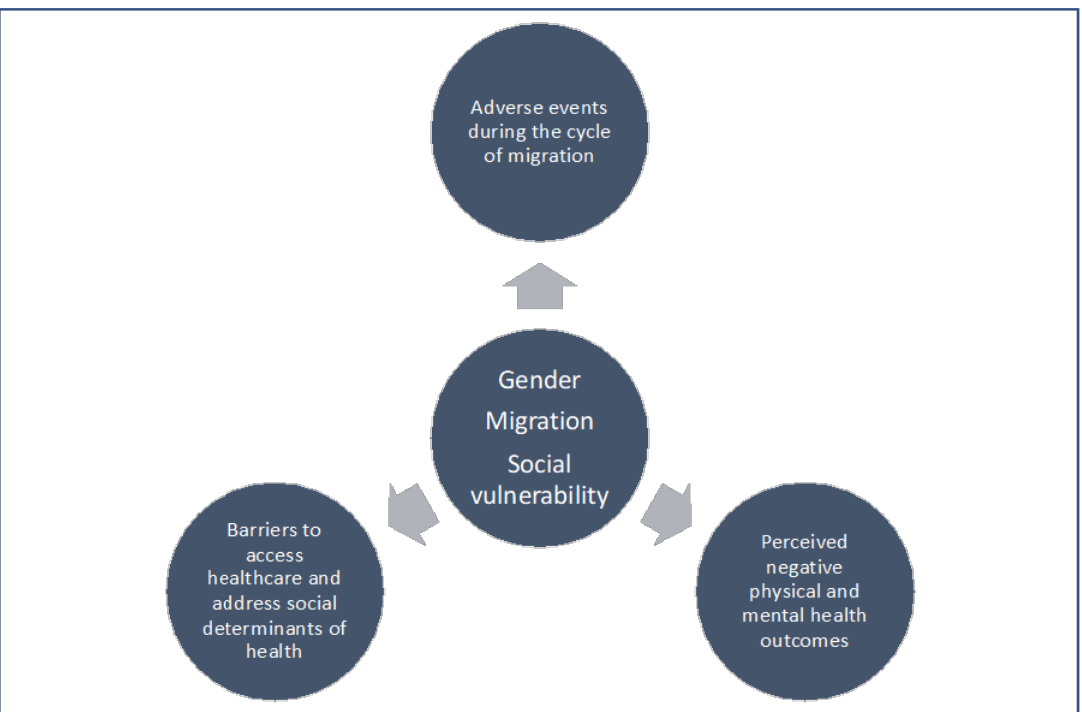
Figure 2. Dimensions of health inequities in the context of intersecting gender, migration, and social vulnerability.